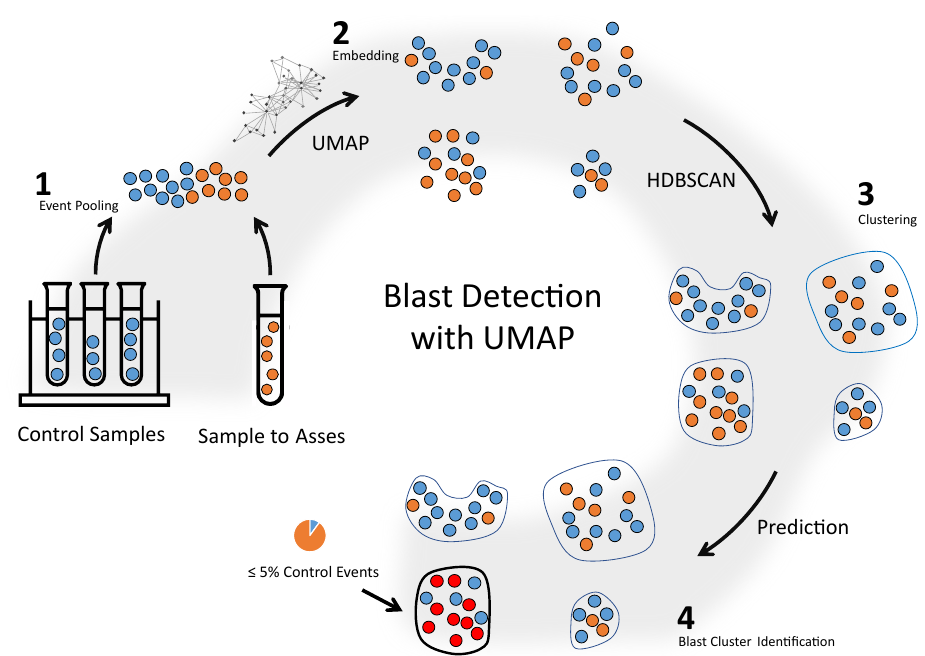
Figure 3. Schematic illustration of the method proposed for automated MRD detection in AML FCM